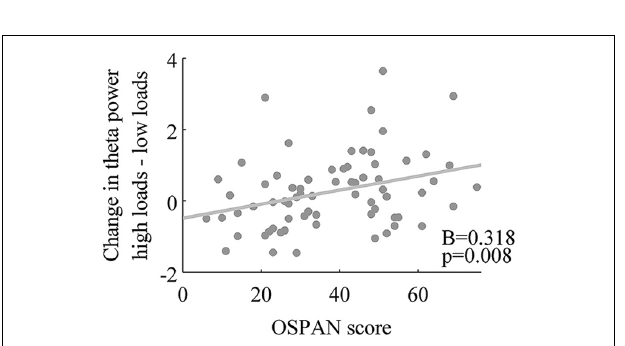
FIGURE 4 | Positive association of working memory capacity and theta power change from low loads to high loads conditions.